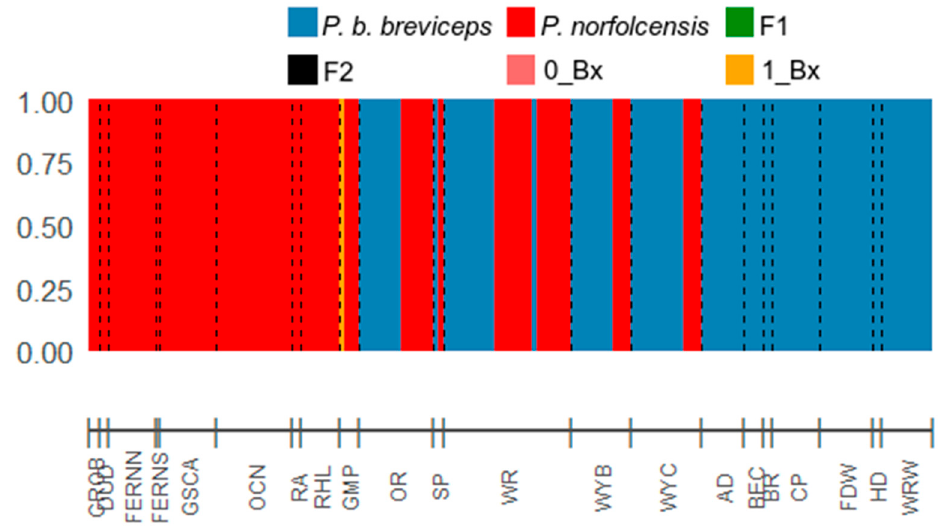
Figure 7. Results of NEWHYBRIDS analysis to identify hybrids between Petaurus species using 10,111 SNPs ( n = 179). Possible results include pure squirrel glider ( P. norfolcensis ), pure sugar glider ( P. b. breviceps ), first generation hybrid (F1), second generation hybrid (F2), backcross to P. b. breviceps (0_Bx), and backcross to P. norfolcensis (1_Bx). Locations are listed along the bar on the x axis (refer to Figure 2 for more information). y -axis indicates assignment probability.